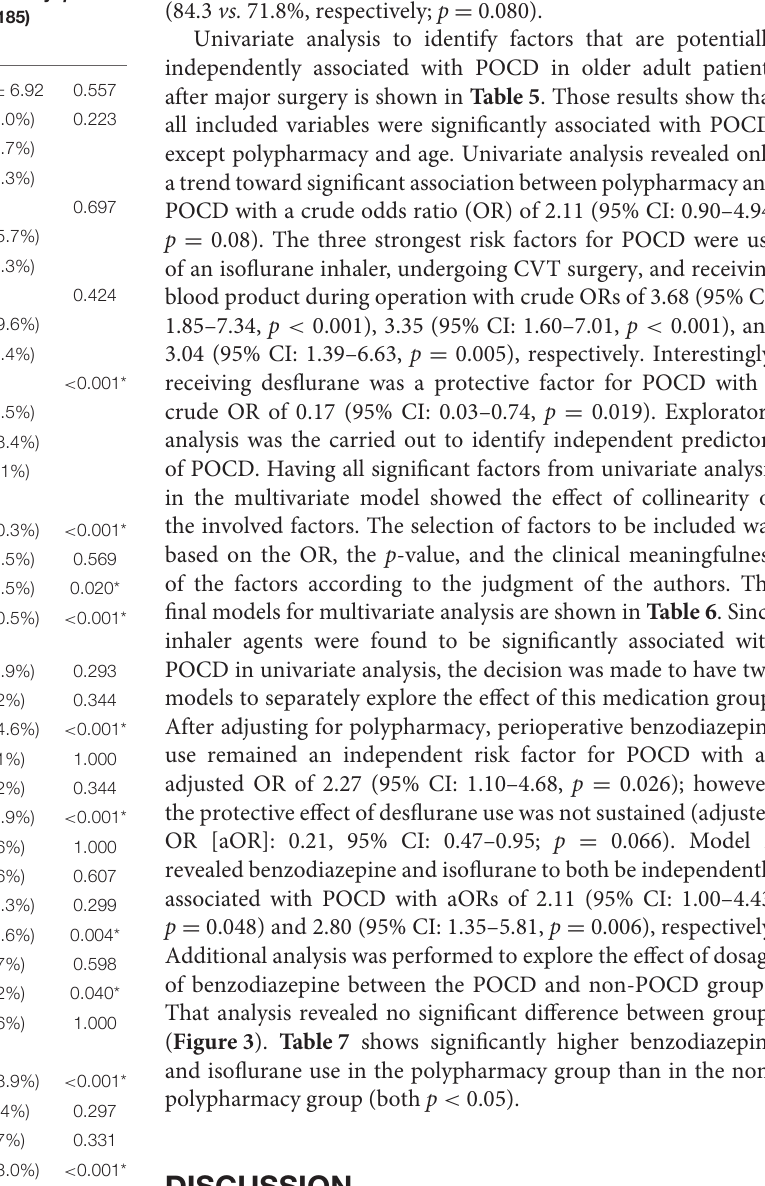
have POCD. More preoperative polypharmacy was identified in the POCD group than in the non-POCD group; however, the difference between groups did not reach statistical significance (84.3 vs. 71.8%, respectively; p = 0.080). Univariate analysis to identify factors that are potentially after major surgery is shown in Table 5 . Those results show that all included variables were significantly associated with